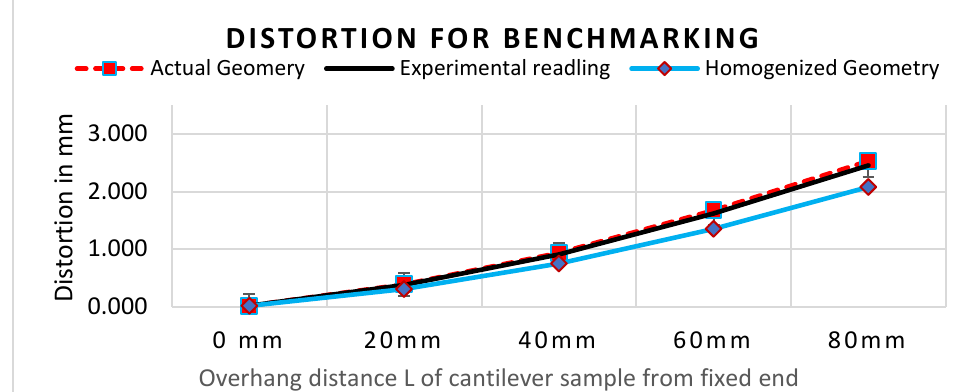
Figure 10. Comparison of distortion measurement without characterization data using only VF.